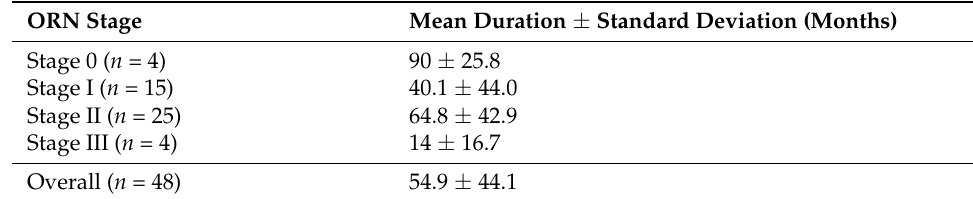
Table 3. The mean onset duration for ORN after RT.